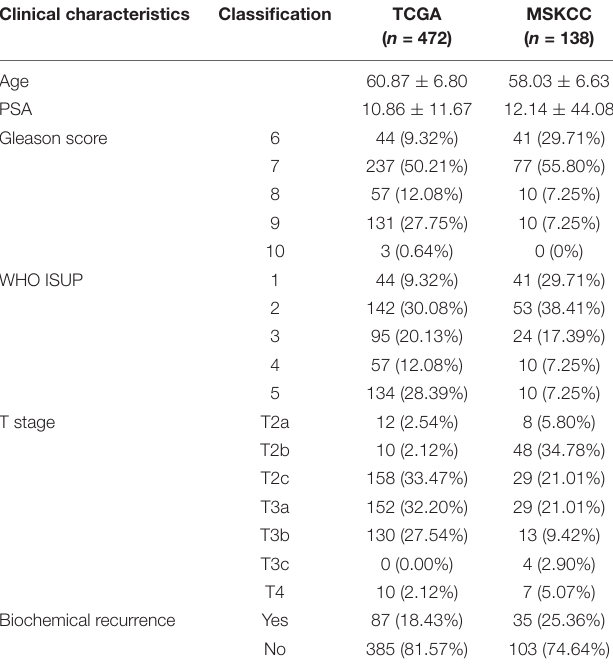
TABLE 1 | The basic characteristics of the two cohorts of